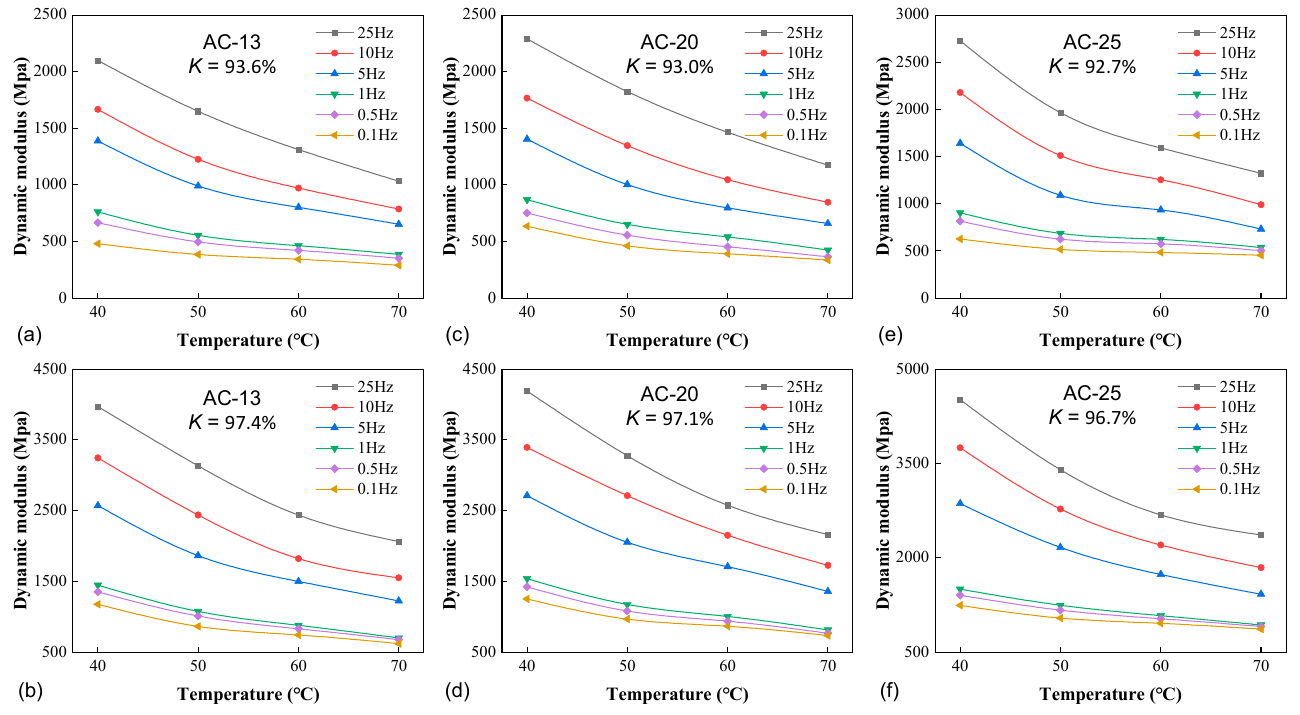
Figure 4. The effect of temperature: ( a ) AC-13 ( K = 93.6%), ( b ) AC-13 ( K = 97.4%), ( c ) AC-20 ( K = 93.0%), ( d ) AC-20 ( K = 97.1%), ( e ) AC-25 ( K = 92.7%), and ( f ) AC-25 ( K = 96.7%).